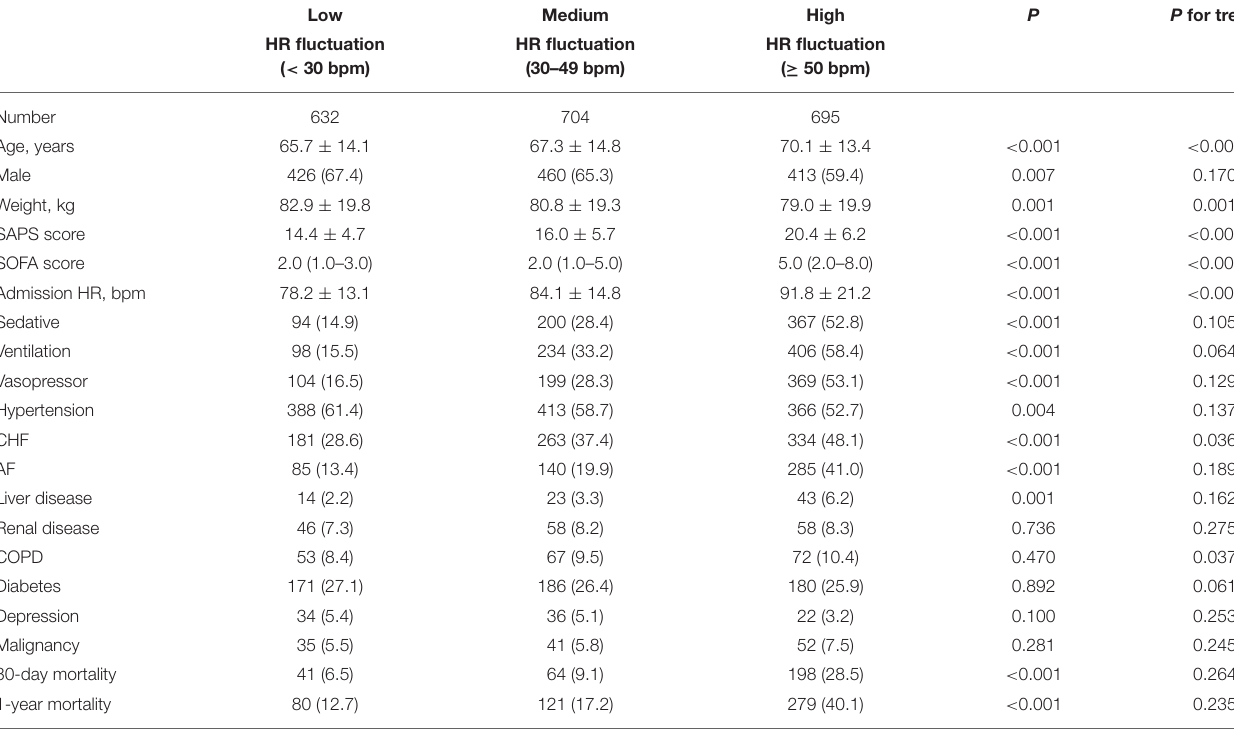
TABLE 1 | Baseline characteristics of enrolled participants grouped by HR fluctuation.